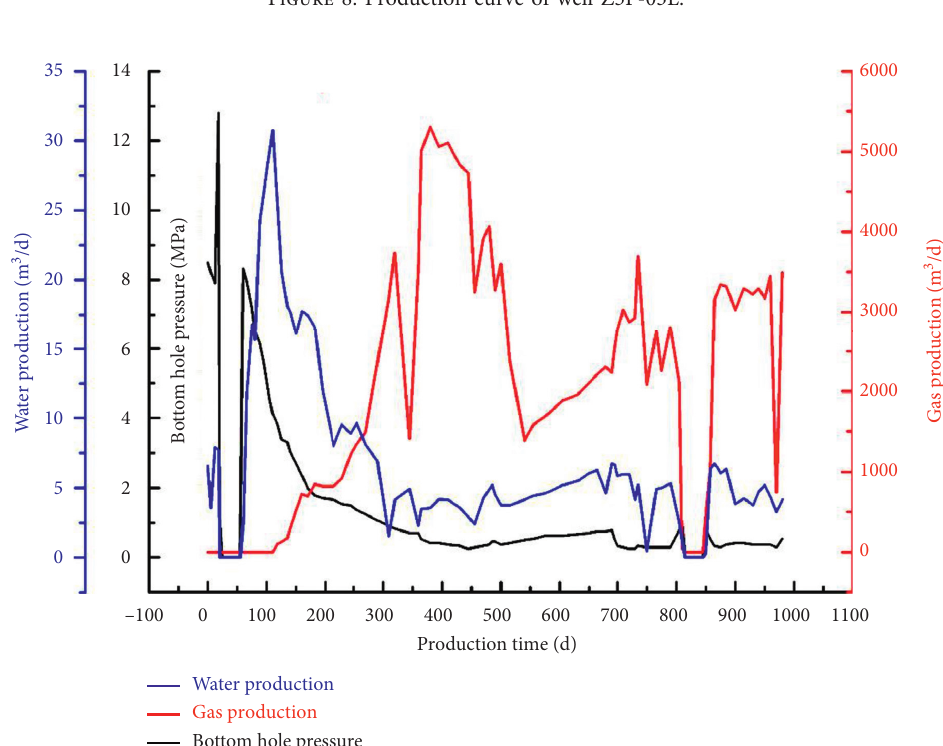
Figure 9: Production curve of well